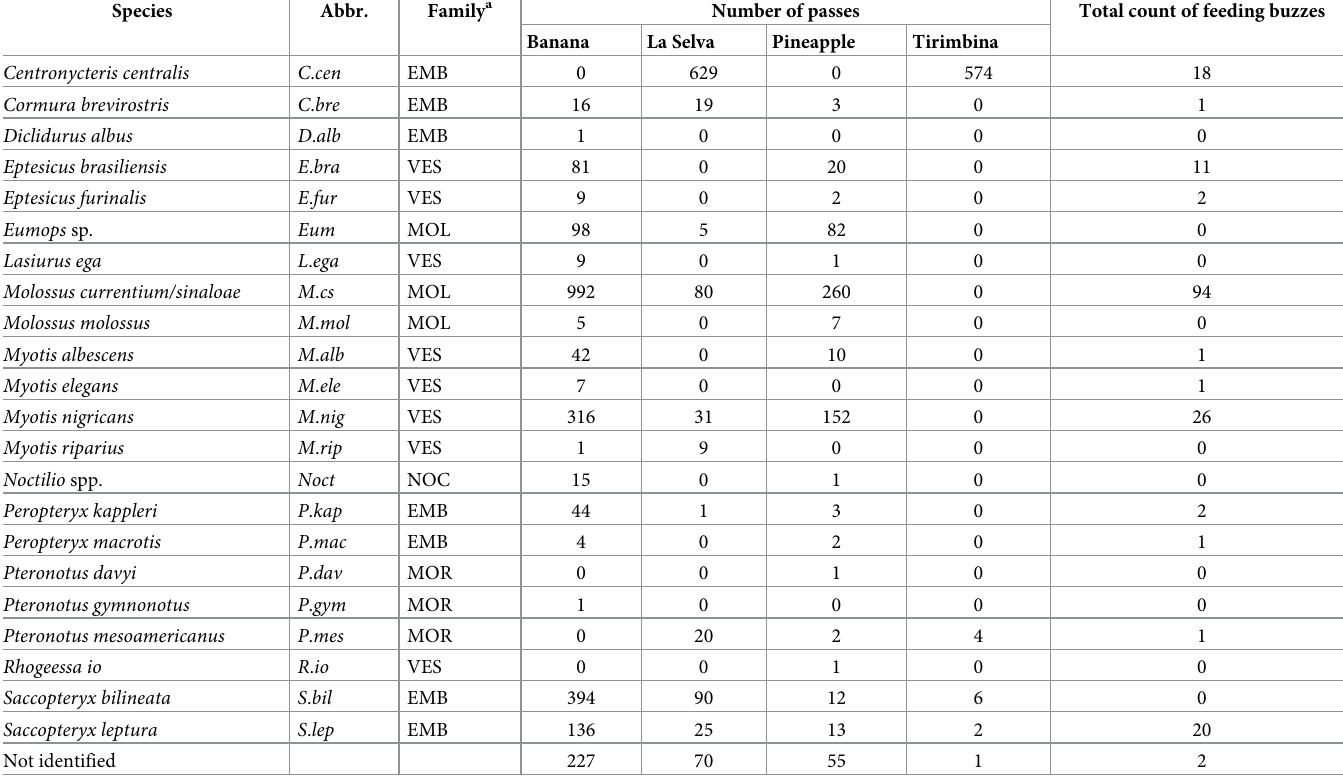
Table 1. Bat activity (total number of passes) and feeding activity (total count of feeding buzzes) of aerial insectivorous bats in each site category by species. Species